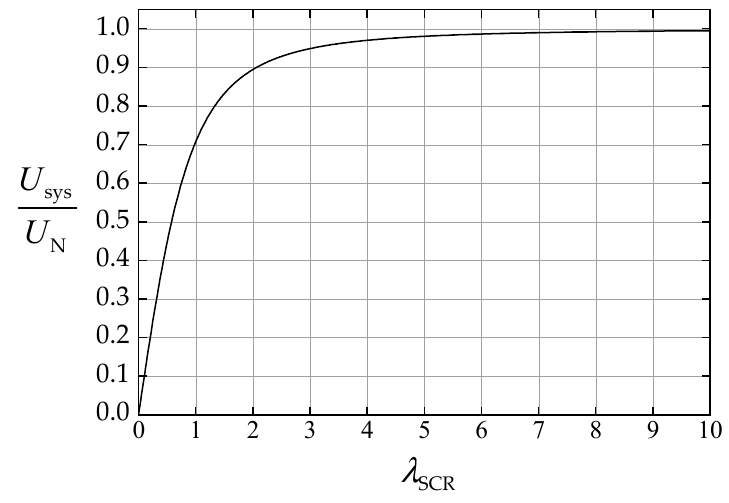
Figure 7. Variation of device voltage with the short-circuit ratio .